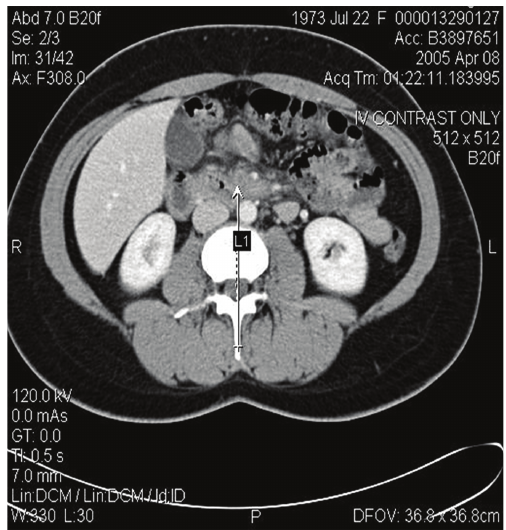
Figure 1: Contrasted abdominal computed tomography demon- strating partial thrombosis of the superior mesenteric vein as noted by the